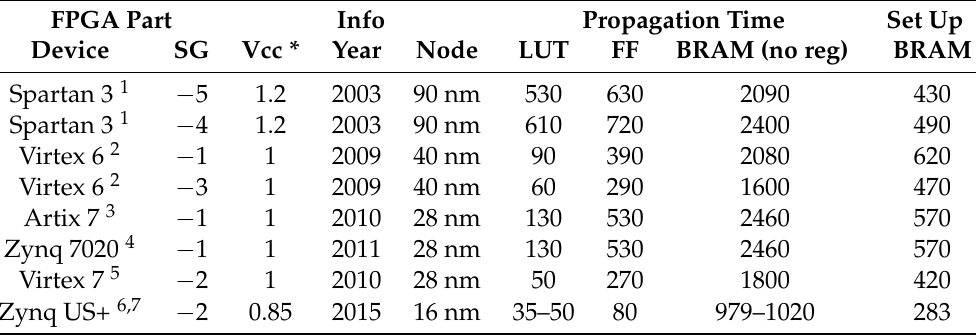
Table 5. Example of FPGA propagation and set-up times relevant to the critical paths present in most implementations for different